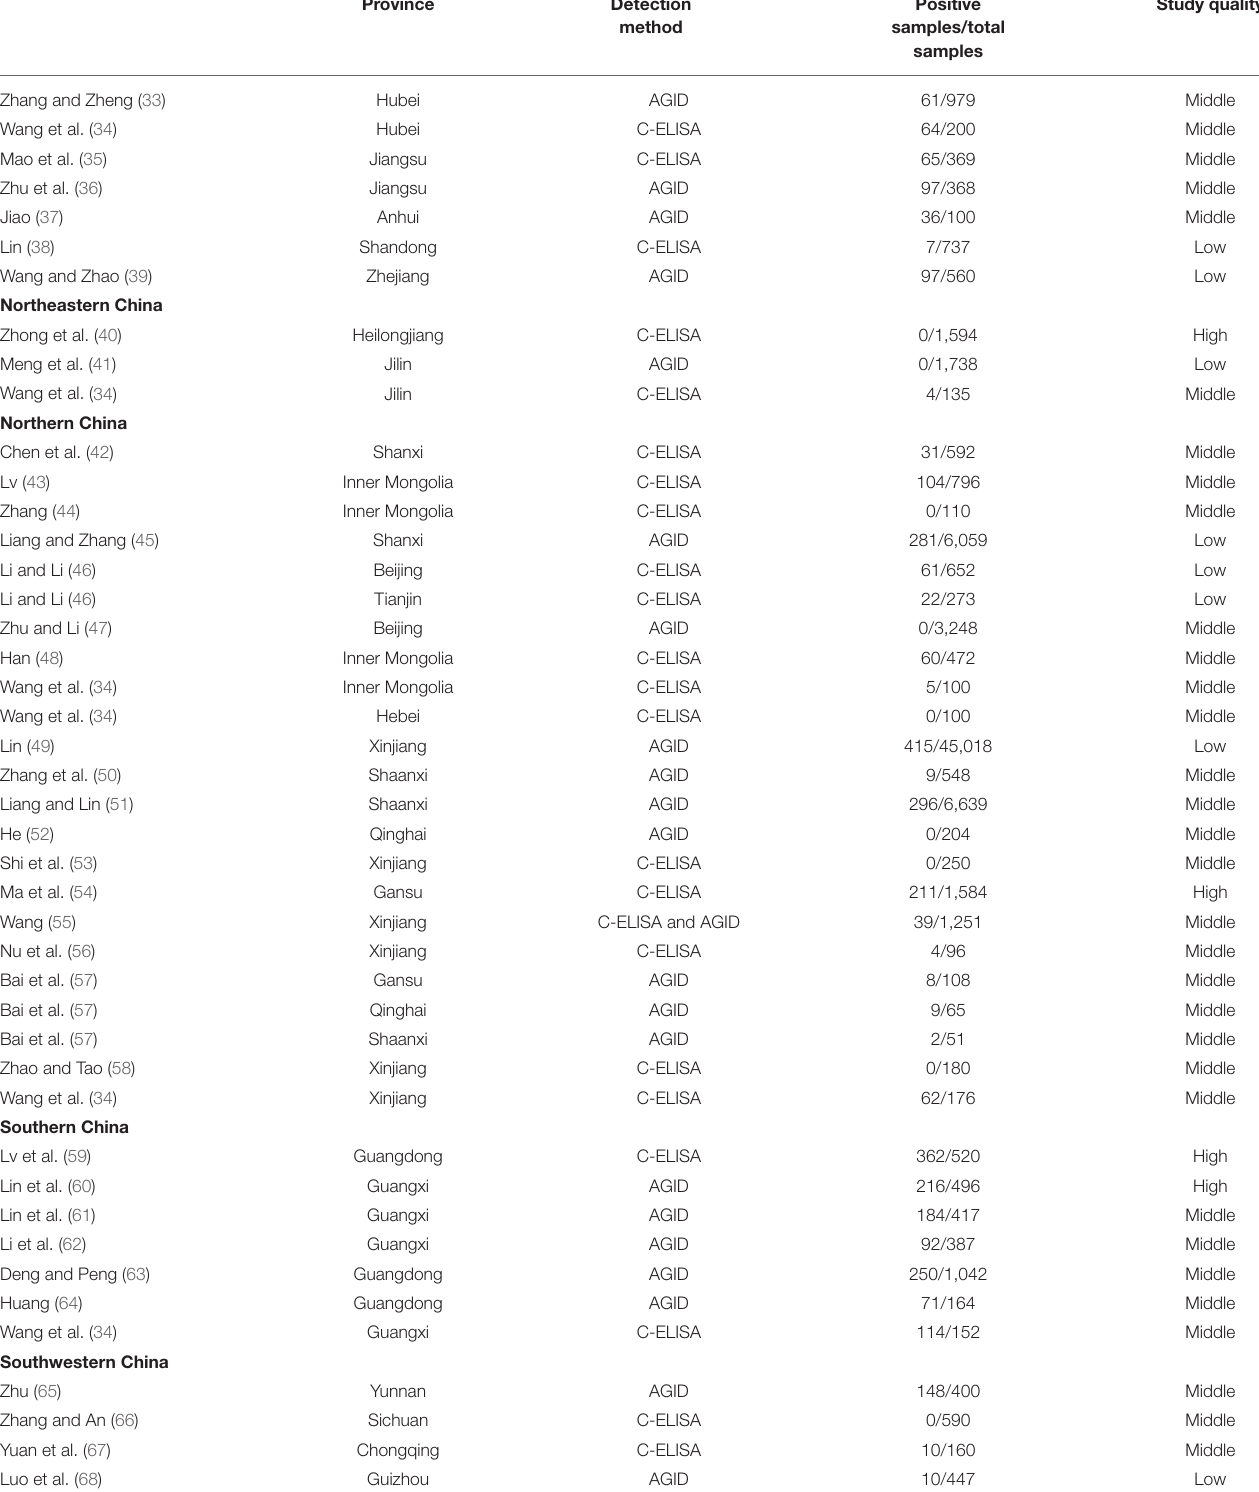
TABLE 2 | Included studies of bluetongue virus in